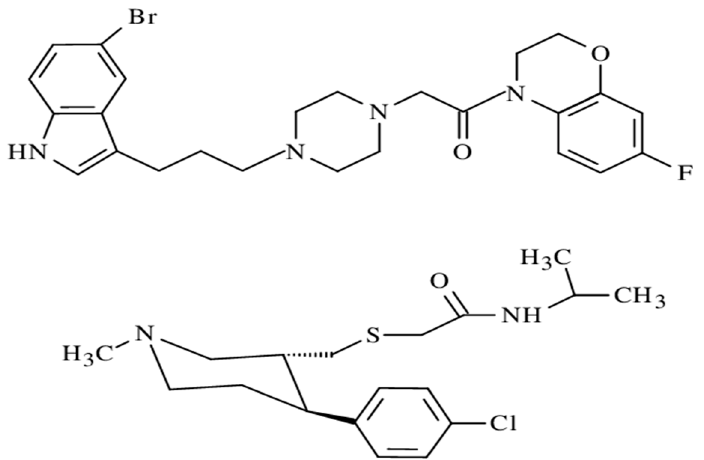
Figure 6. Structures of designed antidepressant hybrids: JZ-IV-10 ( lower structure ) and 7n ( upper structure ).